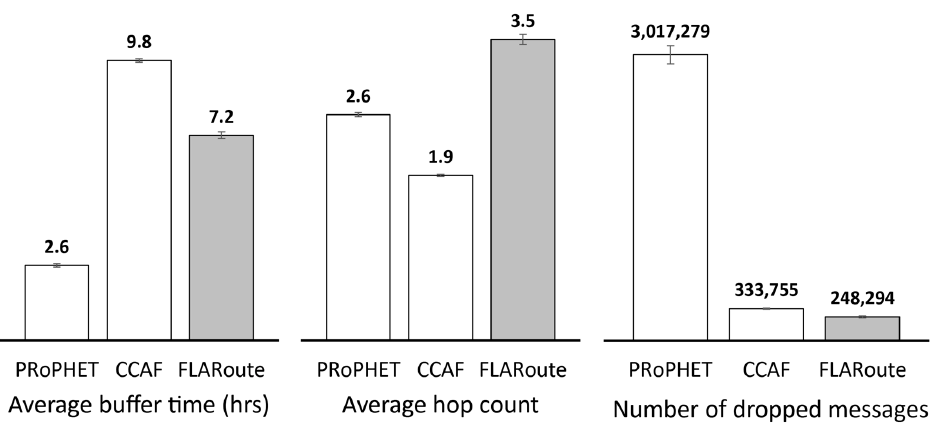
Figure 15. Comparing PRoPHET, CCAF and FLARoute in terms of average buffer time, average hop count and number of dropped messages.